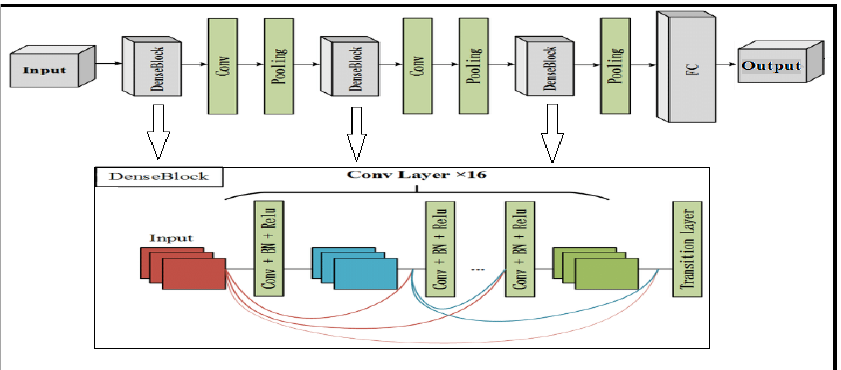
Figure 2. DenseNet-201 architecture.